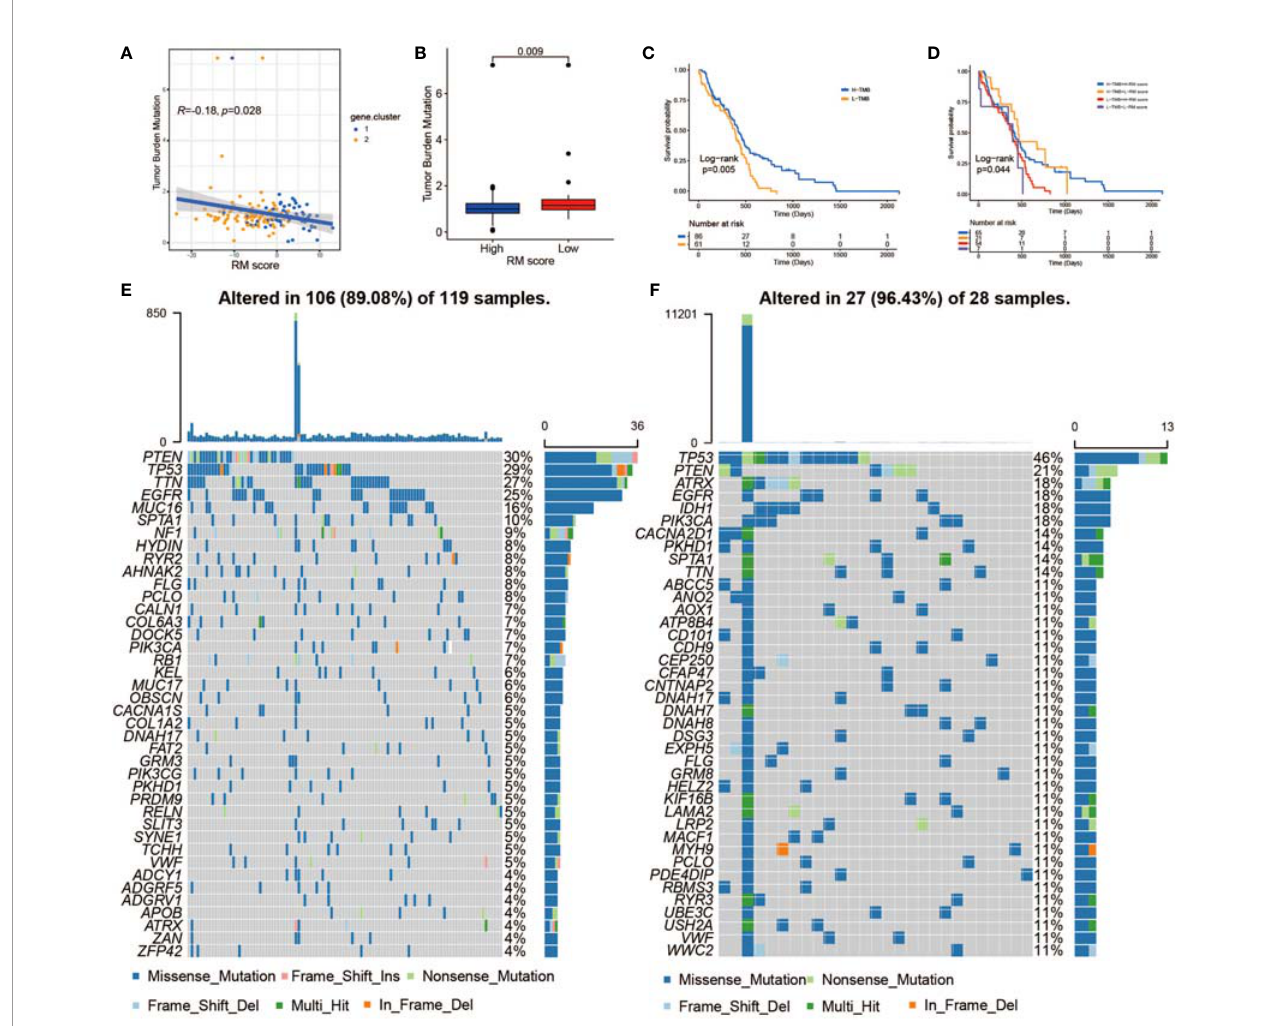
FIGURE 7 | The correlation between the RM score and TME in fi ltration, MES transition, and somatic variants. (A) Scatterplots indicating the negative relationship between RM score and TMB in TCGA-GBMs ( r = − 0.18, p < 0.028, Spearman correlation analysis). (B) TMB difference in the low and high RM score cohorts. (C) KM curves for the low and high TMB GBMs. H, high; L, low. (D) Survival analyses for subgroup GBMs strati fi ed by RM score and TMB. (E, F) Waterfall plot showing tumor somatic mutations presented by those with high RM scores (E) and low RM scores (F)